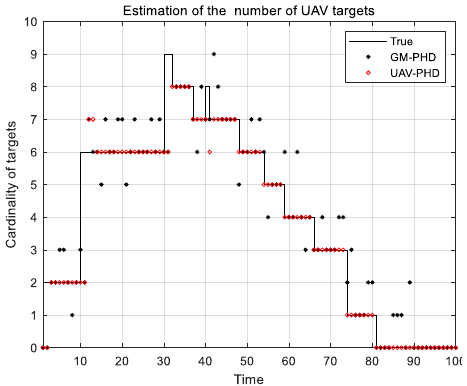
Figure 7. Estimation of the number of UAV targets.